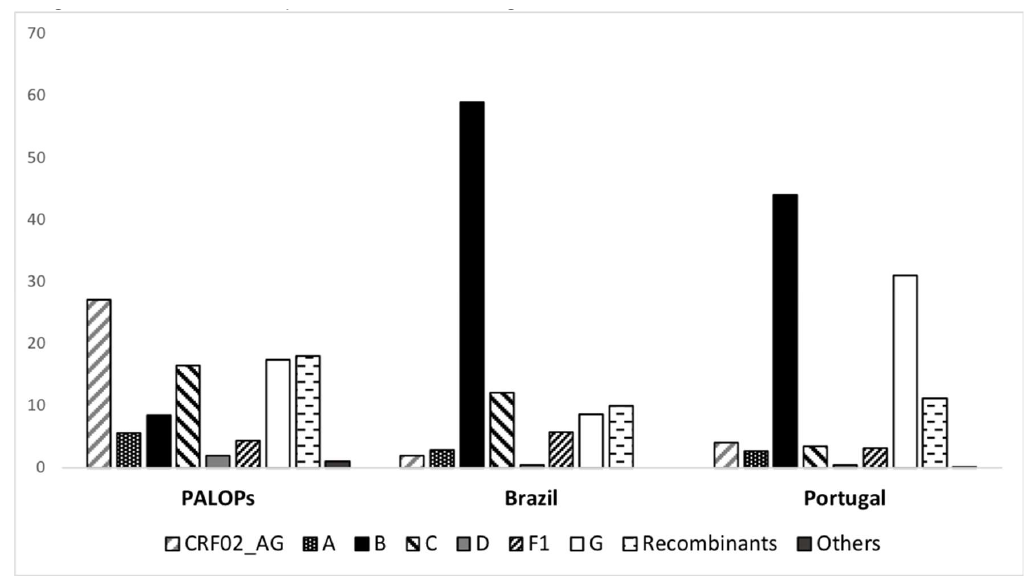
Figure 1. Subtype distribution stratified by country of origin of the patient. Portuguese Speaking African Countries (PALOPs) n = 1281, Brazil n = 209 and Portugal n = 3687.